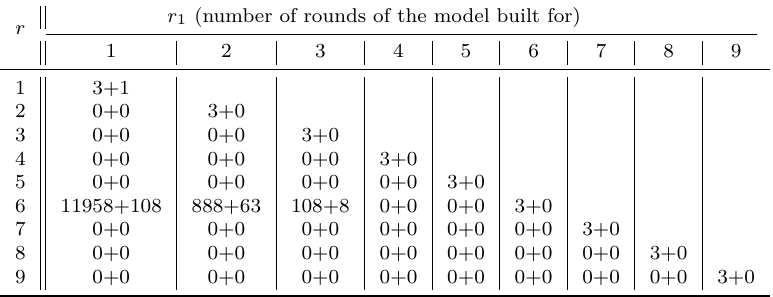
Table 7: Number of MILP models we solved for searching for the best differential charac- teristics for r -round PRESENT by using our algorithm r 1 (number of rounds of the model built for) r 1